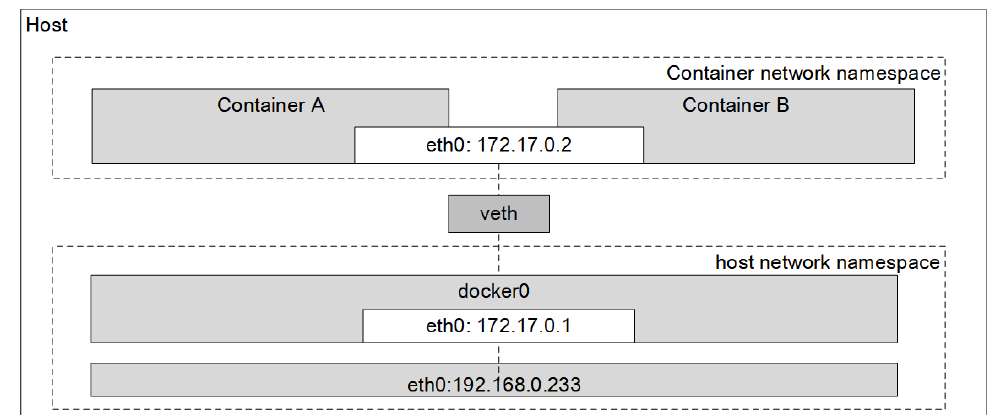
Figure 6. ‘Bridge Mode’ communication method in a single host.